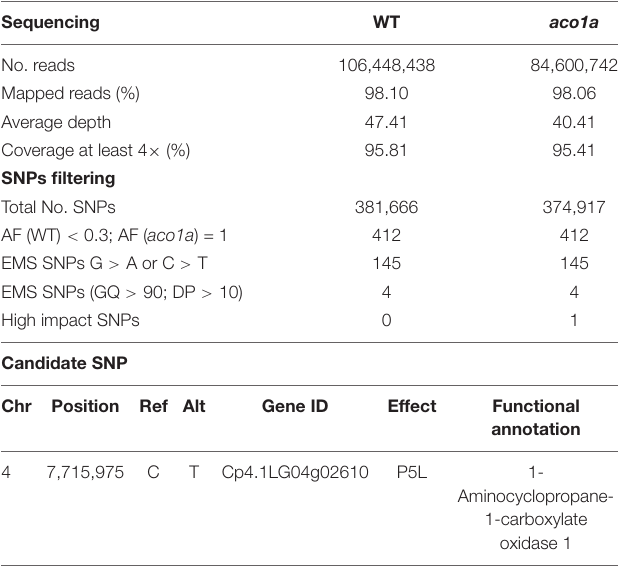
TABLE 1 | Summary sequencing data for WT and aco1a